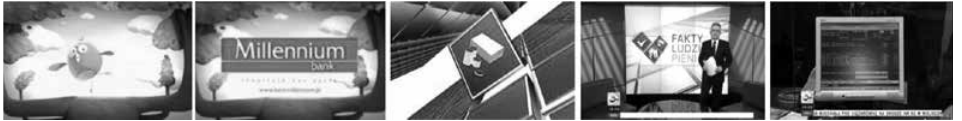
Figure 2(c). Congruent and non-controversial: vignette (bank) attached to a news